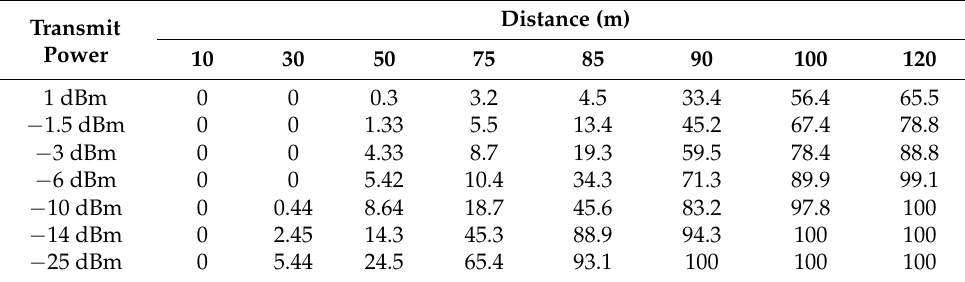
Table 10. Packet loss rate test (LEACH